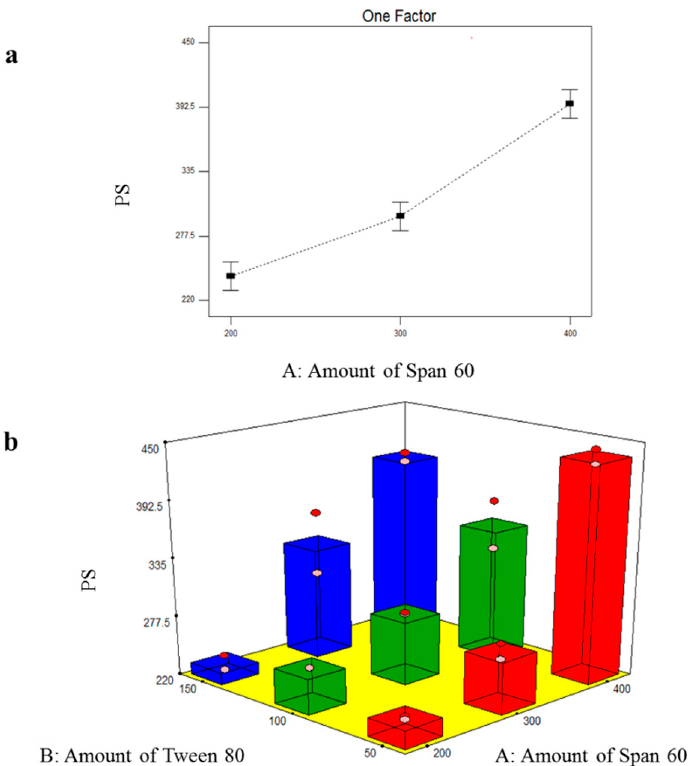
Figure 2. Line plot of the significant effect of Span 60 amount (X 1 ) ( a ) and response 3D plot for the combined effect of Span 60 amount (X 1 ) and Tween 80 amount (X 2 ) ( b ) on PS of TOL basic spanlas- tics.